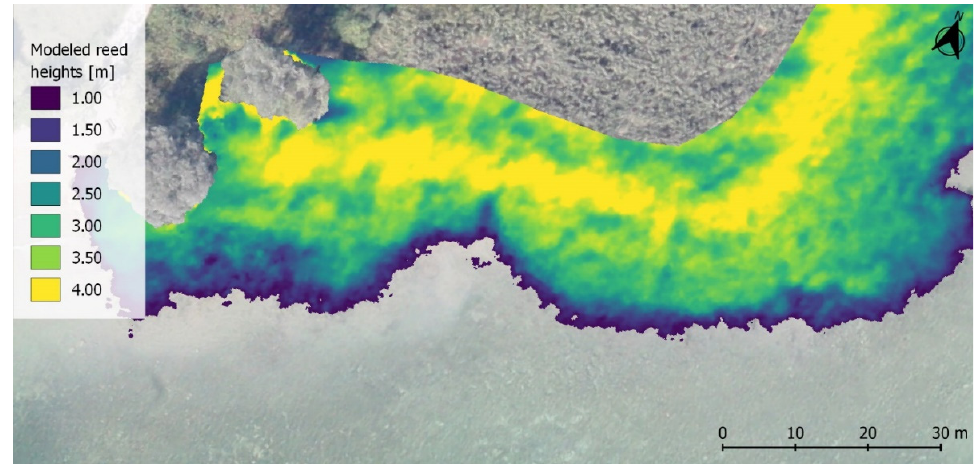
Figure 6. 3K data modeled reed heights at AOI 6.